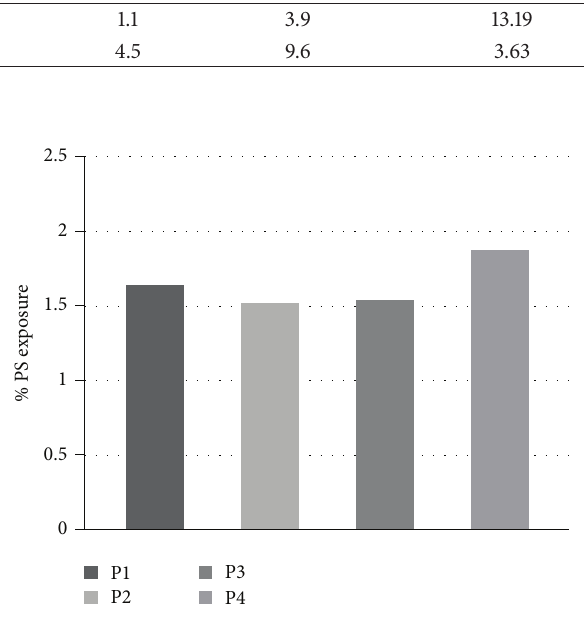
Figure 2: Histogram depicting the % PS asymmetry of the four samples where the 𝑥 -axis denotes the % annexin V-FITC binding or the % PS